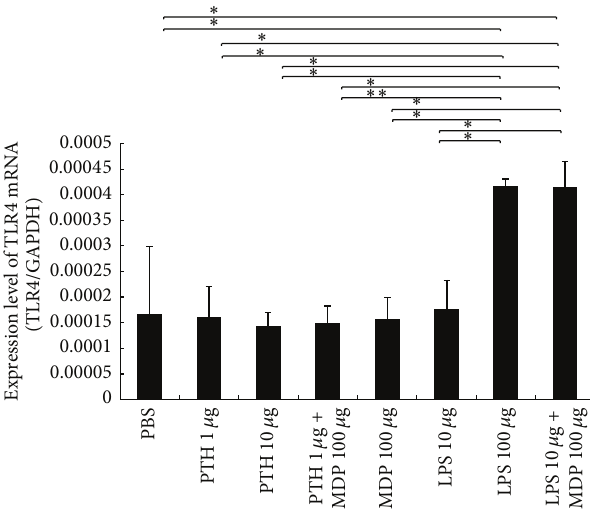
Figure 8: Enhancing lipopolysaccharide- (LPS-) induced Toll-like receptor (TLR4) expression using muramyl dipeptide (MDP) in vitro . Total RNA from bone marrow stromal cells was isolated after 4 days of incubation in culture medium supplemented with 1ng/mL PTH, 10 ng/mL PTH, 1ng/mL PTH and 10 𝜇 g/mL MDP, 10 𝜇 g/mL MDP, 100 ng/mL LPS, or 10 ng/mL LPS + 10 𝜇 g/mL MDP. mRNA levels for TLR4 were normalized to those of GAPDH. Results are expressed as the mean ± SD ( 𝑛 = 4 ; ∗∗ 𝑃 < 0.01 ). Differences were determined using Scheffe’s 𝐹